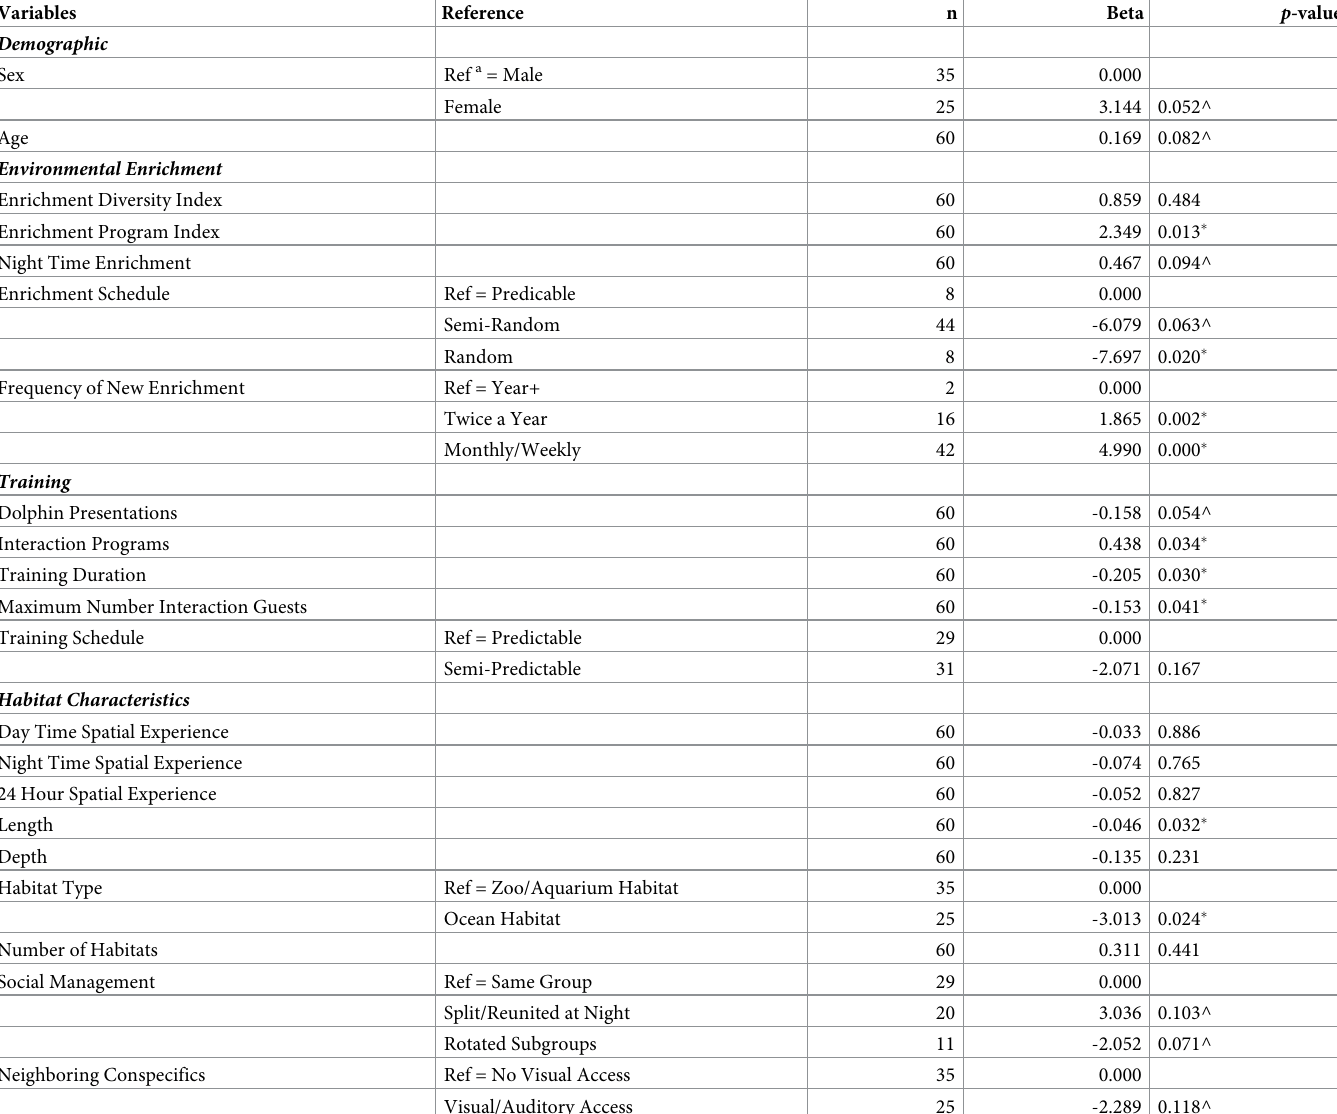
Table 4. Univariate correlations between bottom third habitat use and independent